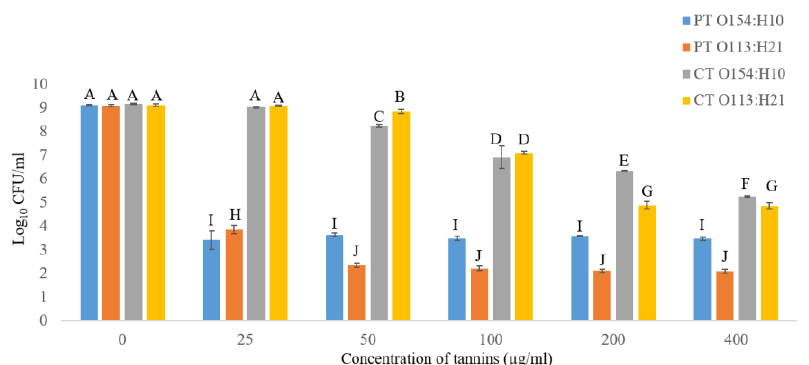
Figure Figure 4. The anti-bacterial effect of condensed tannins (CT) and phlorotannins (PT) at five concentrations (25–400 µg/mL) on E . coli O154:H10 and O113:H21. Different uppercase letters denote differences at p < 0.05 among condensed tannins and phlorotannins. Bars = standard error ( n = 3).